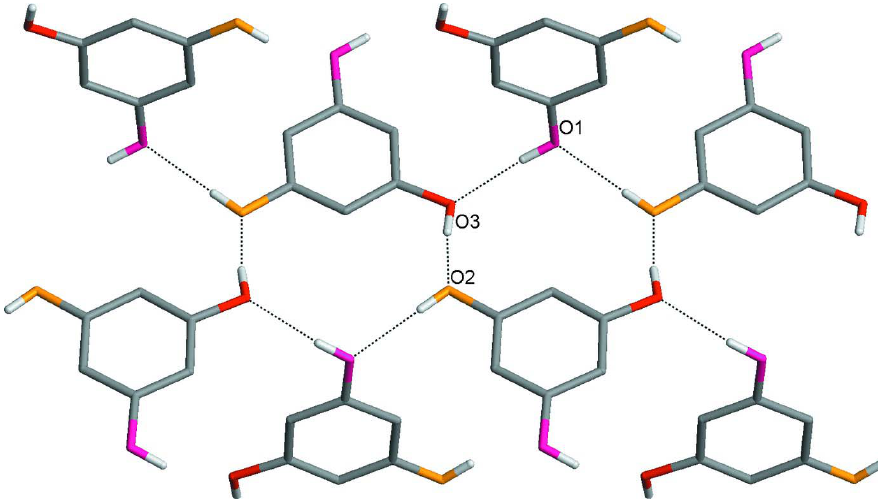
Figure 3 Detail of the hydrogen bonding pattern showing infinite hydrogen-bonded